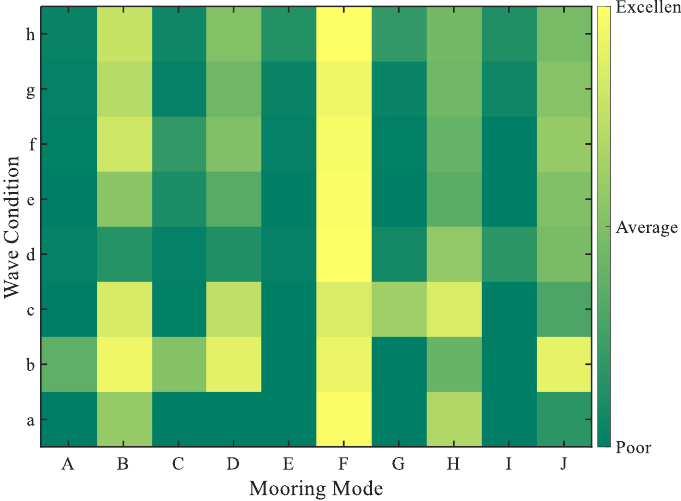
Figure 20. The cloud chart of the number of effective excitations.